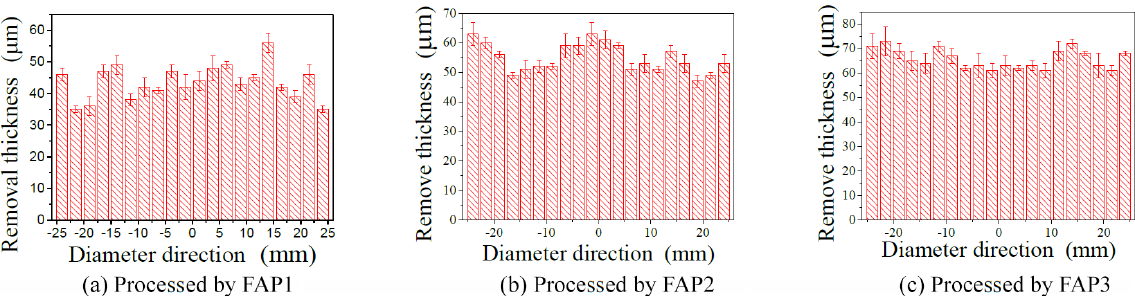
Figure 17. Removal thickness of